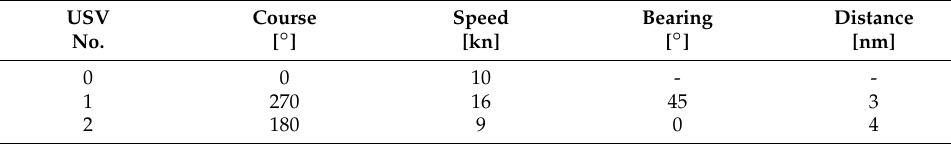
Table 7. Input data of test case 2.